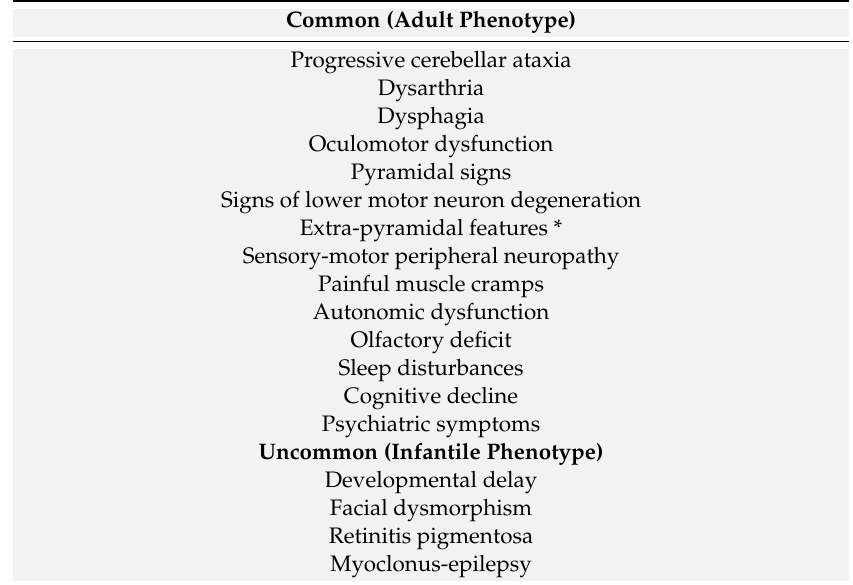
Table 1. Signs and Symptoms of Spinocerebellar ataxia type